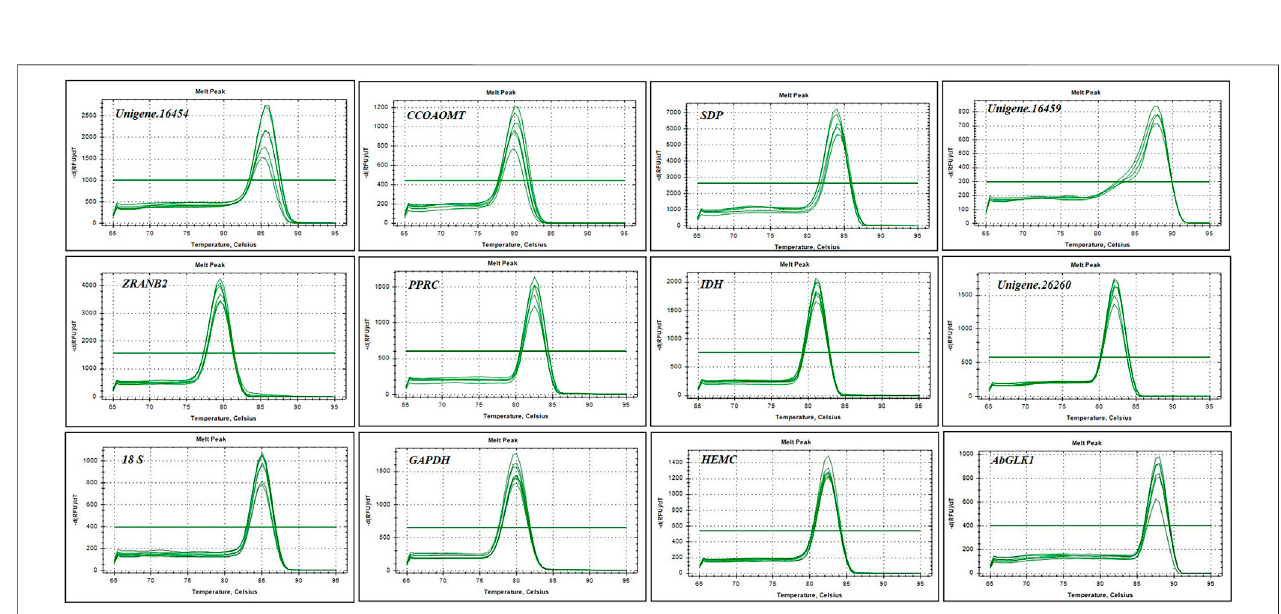
FIGURE 2 | Melting curves of 10 candidate reference genes and two target